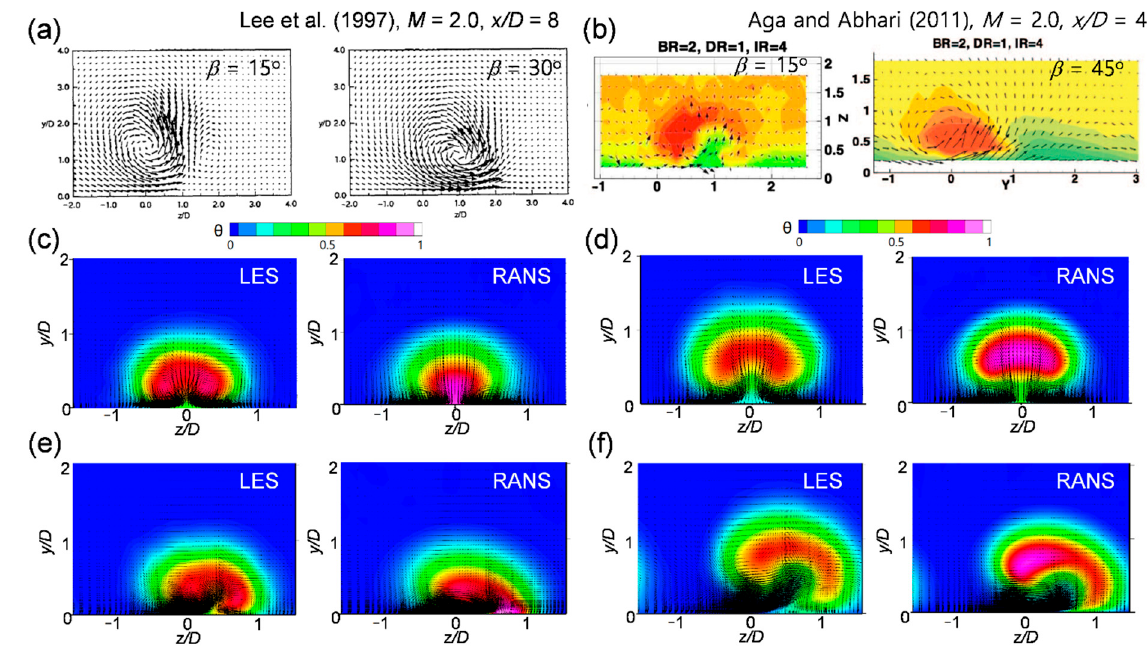
Figure 4. Time-averaged cross-stream velocity vectors with temperature contours at x/D = 2.5: ( a ) Cross-stream velocity vectors reported by Lee et al. [10]; ( b ) cross-stream velocity vectors with streamwise velocity contours, reported by Aga and Abhari [13]; ( c ) M = 0.5, β = 0°; ( d ) M = 1.0, β = 0°; ( e ) M = 0.5, β = 30°; and ( f ) M = 1.0, β = 30°.